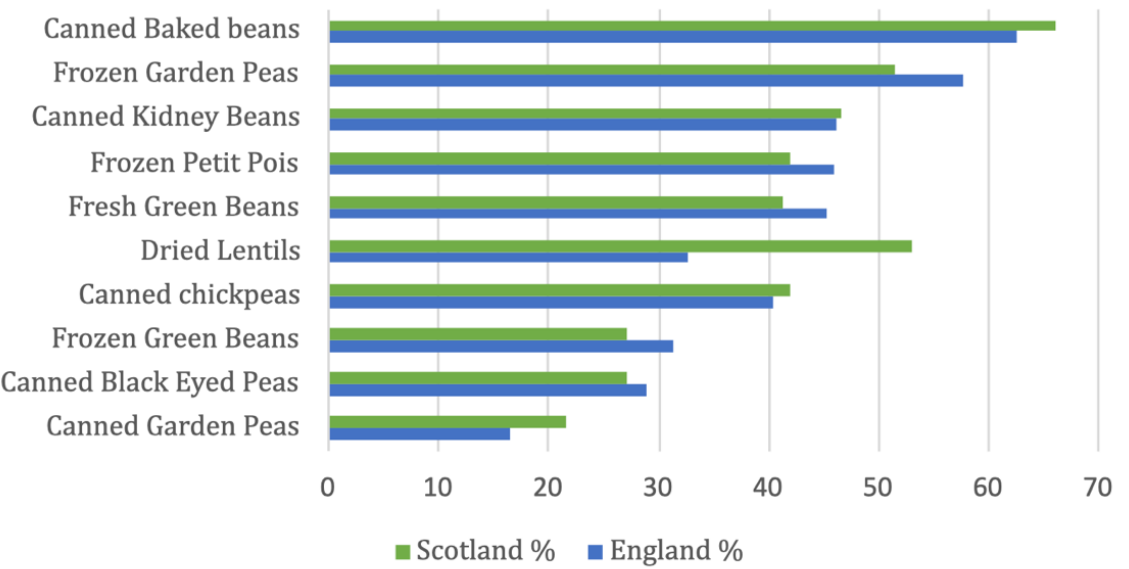
Figure 2. Ten most frequently purchased wholefood plant proteins.